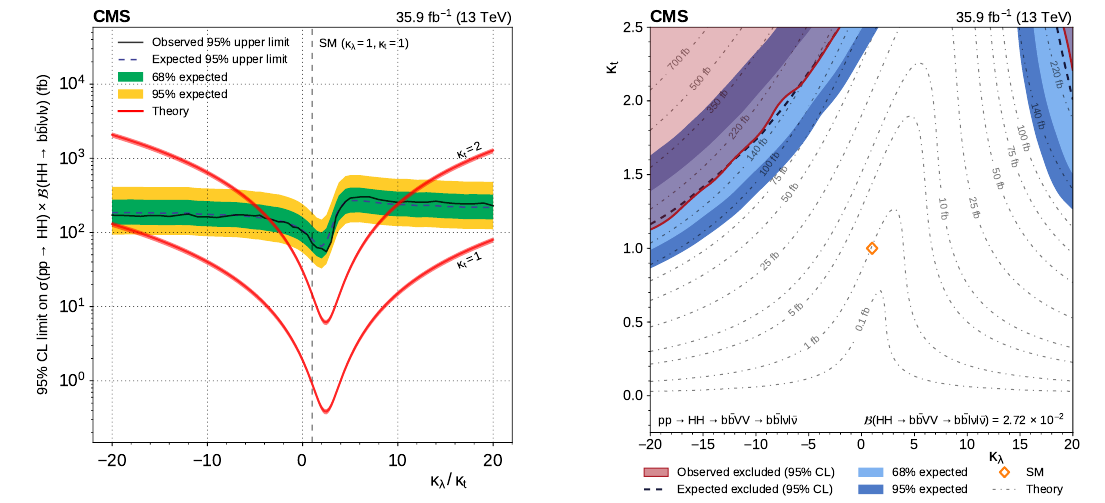
Figure 8 . Left: expected (dashed) and observed (continuous) 95% CL upper limits on the product of the Higgs boson pair production cross section and branching fraction for HH ! bbVV ! bb ‘(cid:23)‘(cid:23) as a function of (cid:20) (cid:21) =(cid:20) t . The inner (green) band and the outer (yellow) band indicate the regions containing 68 and 95%, respectively, of the distribution of limits expected under the background- only hypothesis. Red lines show the theoretical cross sections, along with their uncertainties, for (cid:20) t = 1 (SM) and (cid:20) t = 2. Right: exclusions in the ( (cid:20) (cid:21) , (cid:20) t ) plane. The red region corresponds to parameters excluded at 95% CL with the observed data, whereas the dashed black line and the blue areas correspond to the expected exclusions and the 68 and 95% bands (light and dark respectively). Isolines of the product of the theoretical cross section and branching fraction for HH ! bbVV ! bb ‘(cid:23)‘(cid:23) are shown as dashed-dotted lines. The diamond marker indicates the prediction of the SM. All theoretical predictions are extracted from refs. [12{17,